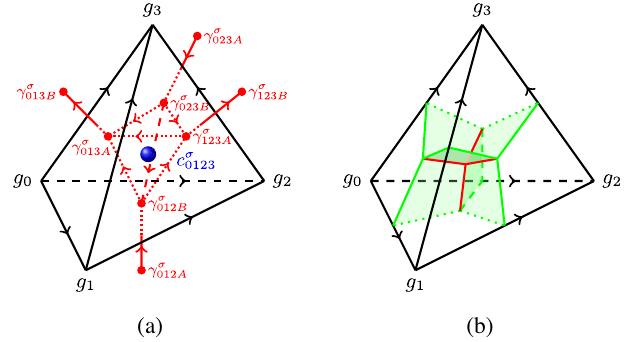
FIG. 8. Four layers of degrees of freedom in a tetrahedron of a 3D triangulation lattice. (a) Layers of bosonic state j g on each i i vertex i , complex fermions c σ at the center of each tetrahedron ijkl on the two sides of each h ijkl i , and Majorana fermions γ σ ijk;A=B triangle h ijk i . (b) Layer of a 2D p þ ip chiral superconductor on the (green) plane dual to each link h ij i . The boundary chiral Majorana modes of the p þ ip superconductors are along the (red) intersecting lines of the (green)